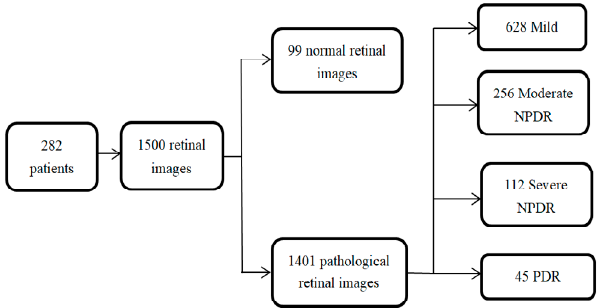
Figure 2. Distribution of clinically acquired database images among various stages of diabetic